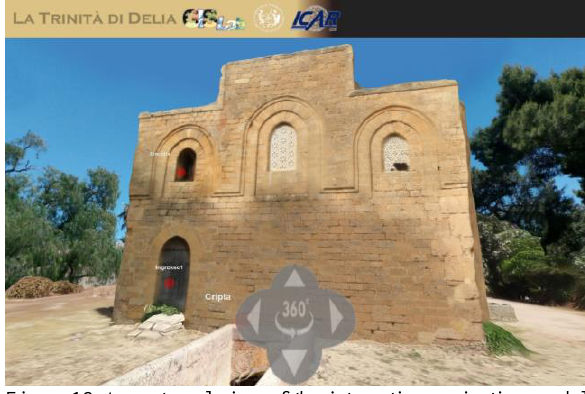
Figure 12. An external view of the interactive navigation model accessible on web.